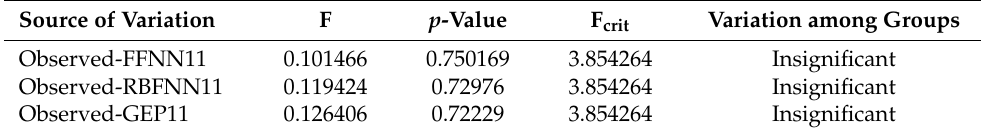
Table 12. Single-factor ANOVA results for the optimum combination of inputs.